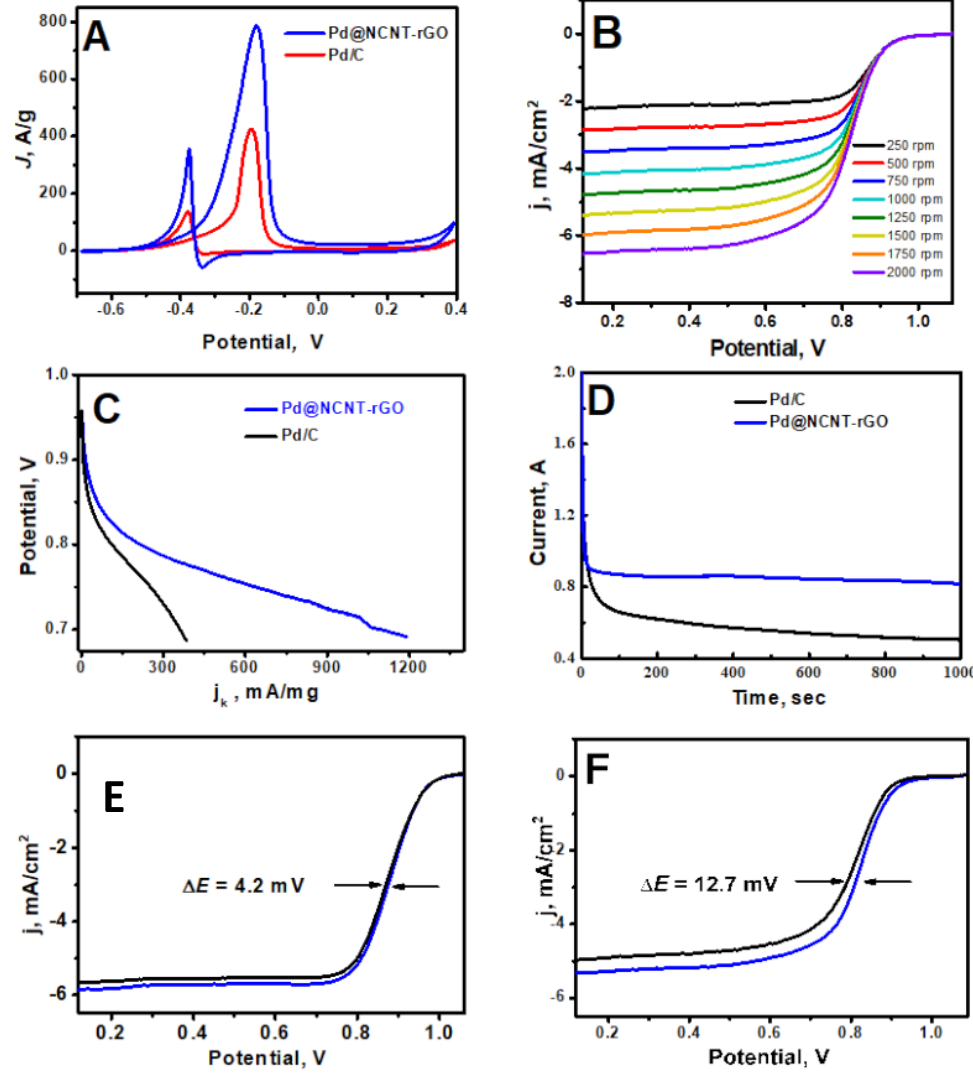
Figure 3. ( A ) CVs of Pd/C and Pd@NCNT-rGO in aqueous 1 M KOH + 1 M methanol solution at a scan rate of 50 mV/s. ( B ) ORR polarization curves of Pd@NCNT-rGO at different rotation rates. ( C ) Kinetic currents density (jk) at different potentials. ( D ) Current density–time curves. ( E , F ) The ORR polarization curves of Pd@NCNT-rGO and Pd/C before and after 1000 cycles, respectively.